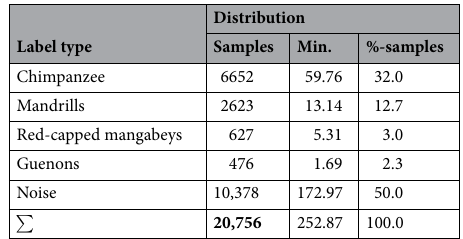
Table 4. The INTERSPEECH 2021 Computational Paralinguistics Challenge Primate (ComParE-PRS) 37,38 data archive and distribution. Significant values are in